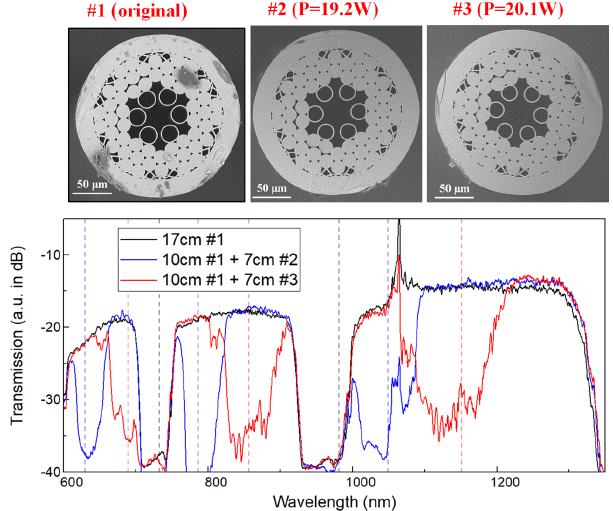
Figure 4. Transmission spectra of different fiber combinations. Fiber #1: unprocessed fiber, t = 1.40 µ m, D = 31.2 µ m; Fiber #2: processed under P = 19.2 W, t = 1.49 µ m, D = 33.2 µ m; Fiber #3: processed under P = 20.1 W, t = 1.63 µ m, D = 36.5 µ m. Resonant wavelengths of Fiber #1, Fiber #2 and Fiber #3 are calculated from Equation (1) and marked with dashed black lines, dashed blue lines and dashed red lines